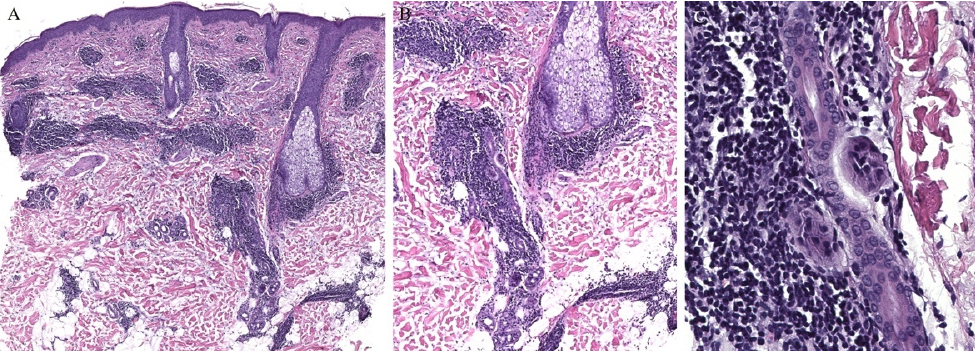
Figure 5. ( A – C ) Lupus erythematosus with periadnexal